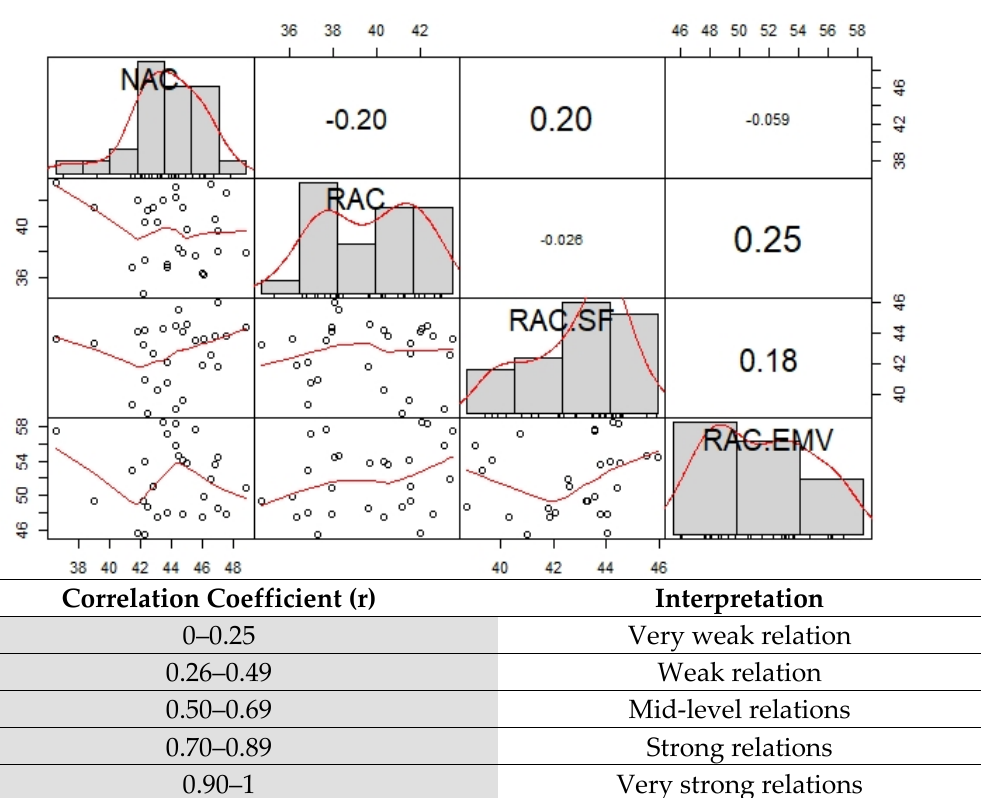
Figure 2. The Pearson Correlation coefficient results. A scatterplot gives the relations between two variables measured for the dataset. Each individual in the data appears as a point on the graph. It is convenient to use scatter